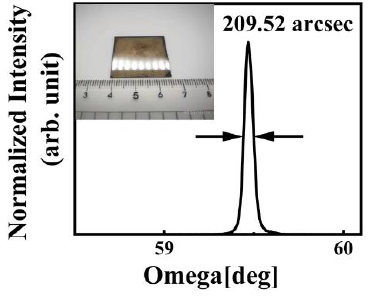
Figure 1. X-ray rocking curve of HSCD.